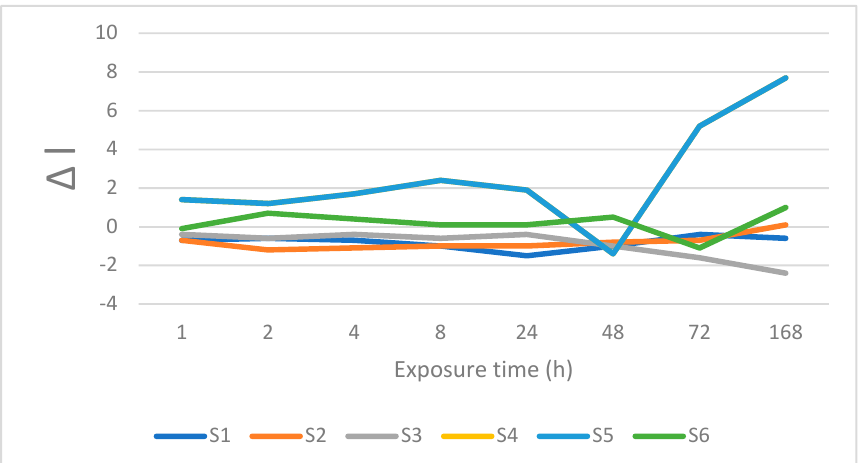
Figure 6. Changes is lightness after immersion in sweetened coffee.